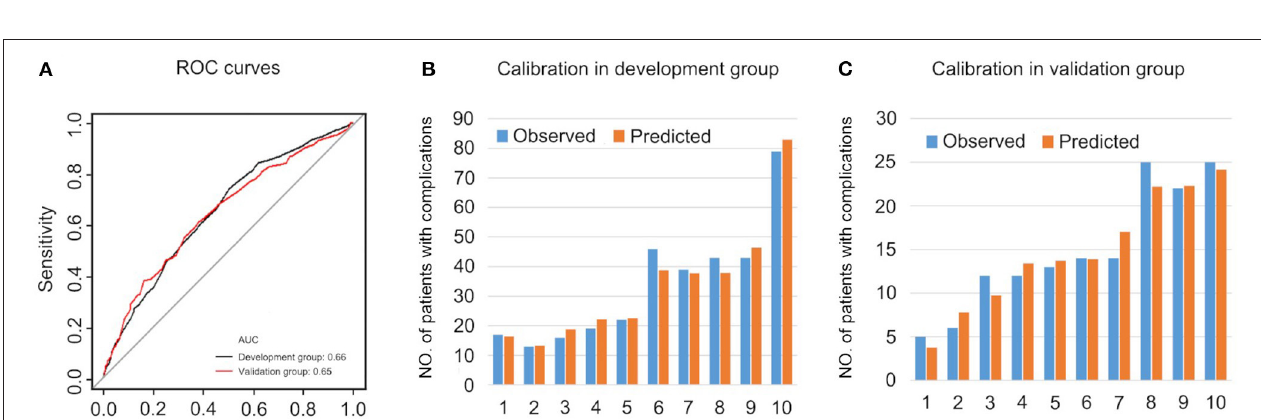
FIGURE 5 | Nomogram to predict the probability of complications. An example of how to use the nomogram: a 33-year-old man received extratemporal resection for refractory epilepsy; the duration of surgical procedure was 6h; the total points for each risk factor add up to 223; a vertical line was then drawn from 223 on the “Total points” line down to the last line to predict the probability of complications (45%).